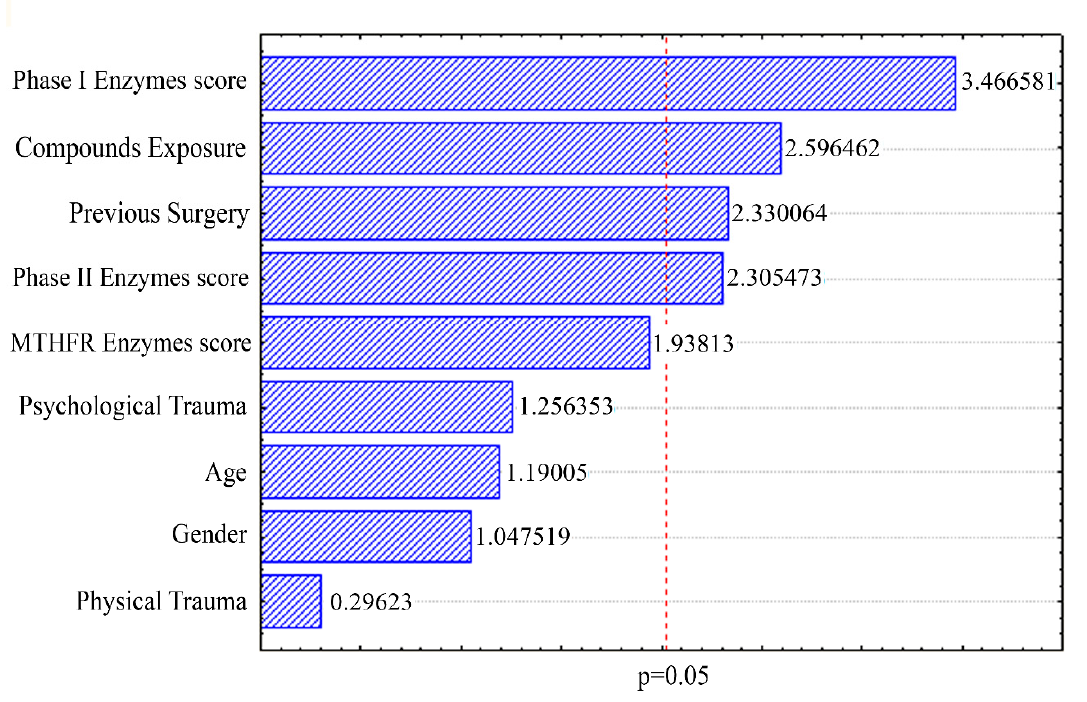
Figure 1. Pareto chart of t-values for all coefficients in the regression models. Pareto chart contrasting t-values of all coefficients accounting for the regression model with the significant p-value cut-off (vertical dotted red line).